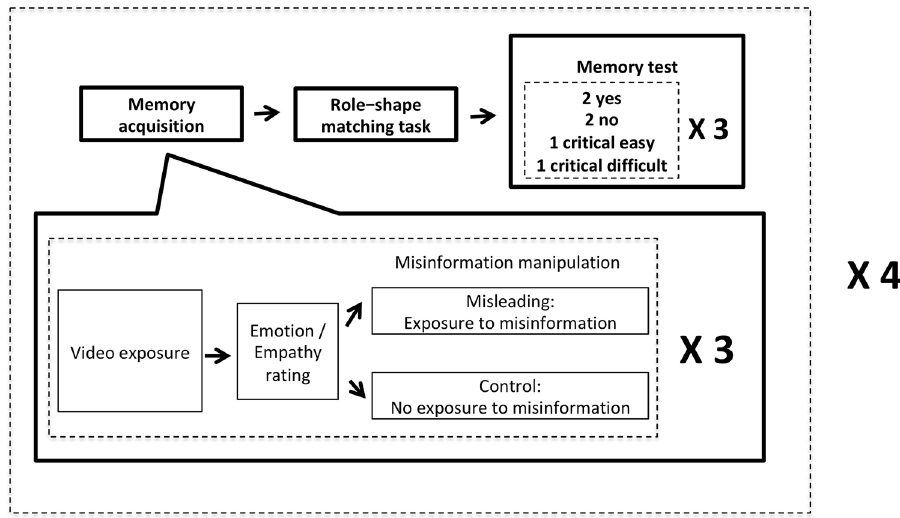
Figure 2. The structure of the experimental procedure. After filling out the IRI scale, the participants started with the memory acquisition stage, where they watched a video, summarized its contents, and rated the emotion and empathy indices about the video. In the misinformation manipulation stage, half of the participants were fed misinformation whereas the other half was not. After three cycles of video exposure, emotion/empathy rating, and misinformation manipulation for three videos, participants proceeded to the role–shape matching task, followed by the memory test stage, where they answered six questions for each video. The aforementioned procedure was repeated four times; therefore, each participant viewed 12 videos to complete the experimental